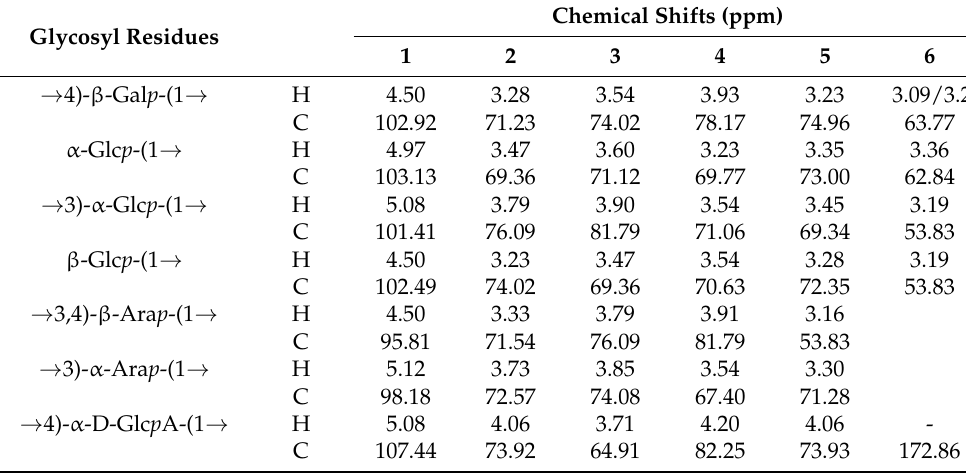
Table 4. Chemical shifts in resonances in the NMR spectra of LBPs-2. Glycosyl